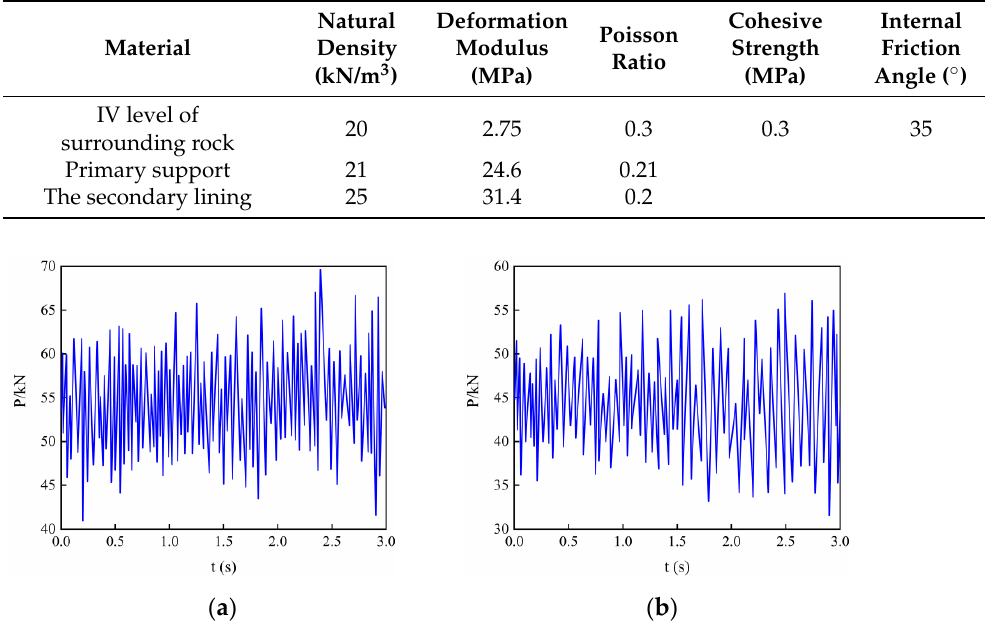
Figure 7. Vibration load time curve of train: ( a ) left side vertical force simulation value; ( b ) right side sag force simulation value.